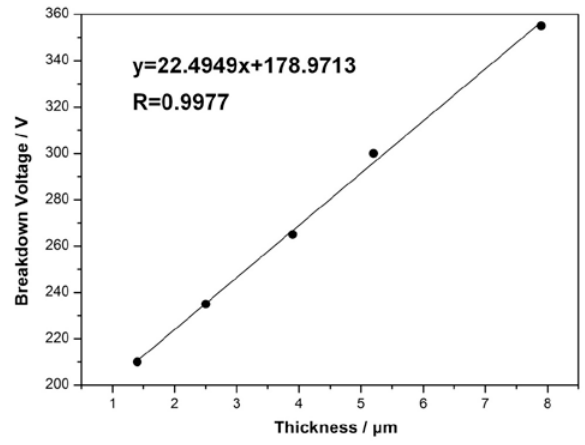
Figure 8. Breakdown voltages of the PFMA dielectric layer with different thicknesses.